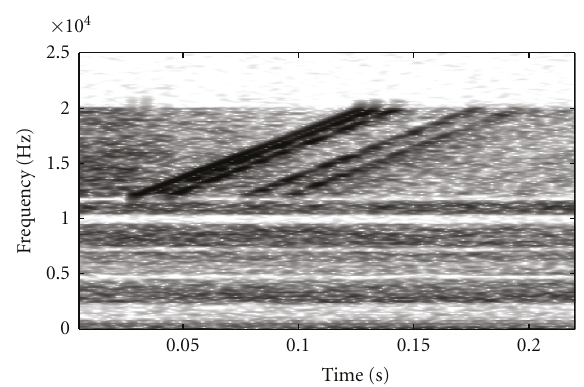
Figure 3: Spectrogram time-frequency representation of the received communication and probing LFM signals transmitted by the towed source in the KAM08 experiment, demonstrating the e ff ects of the multipath underwater propagation (especially the time-delayed arrivals of the LFM signal).